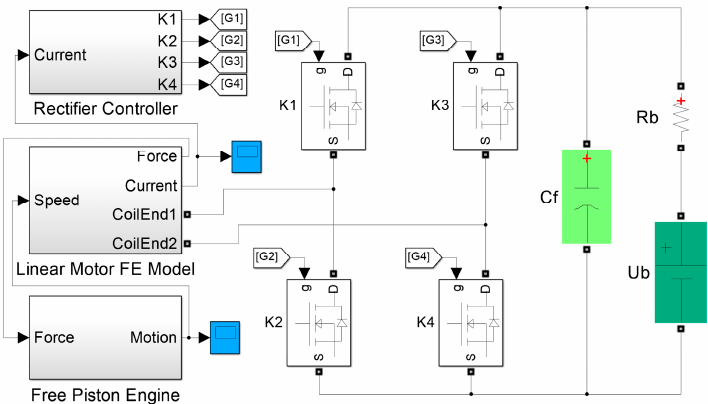
Figure 6. Combined model of the linear motor system.